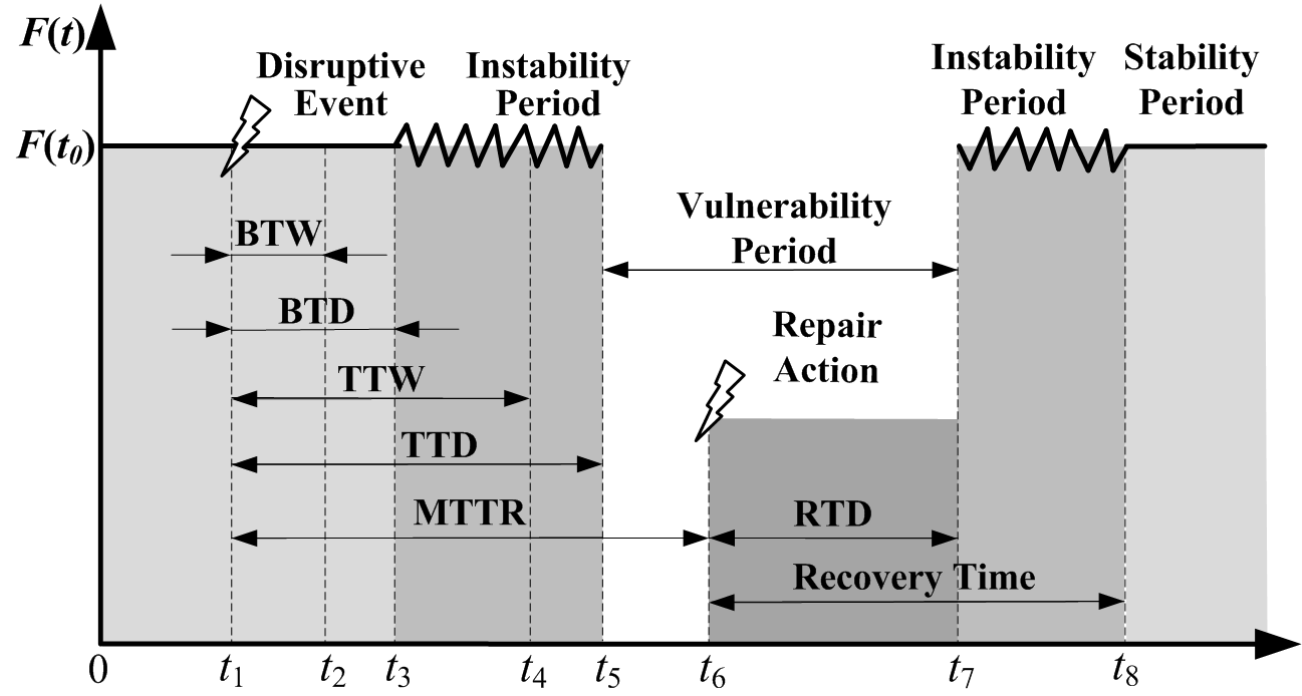
≤ k ). Figure 7. Description of temporal dynamics of a disruptive event ( i ≤ k ).